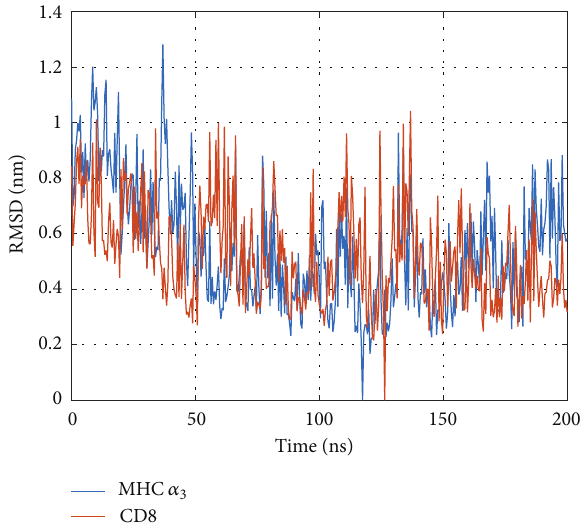
Figure 5: RMSD from central frame of each domain to all other frames of trajectory. Note that RMSD is zero for the respective reference frames against themselves by definition ( 𝑘 𝑉 = 237 ≡ 117.30ns and 𝑘 𝑊 = 255 ≡ 126.25